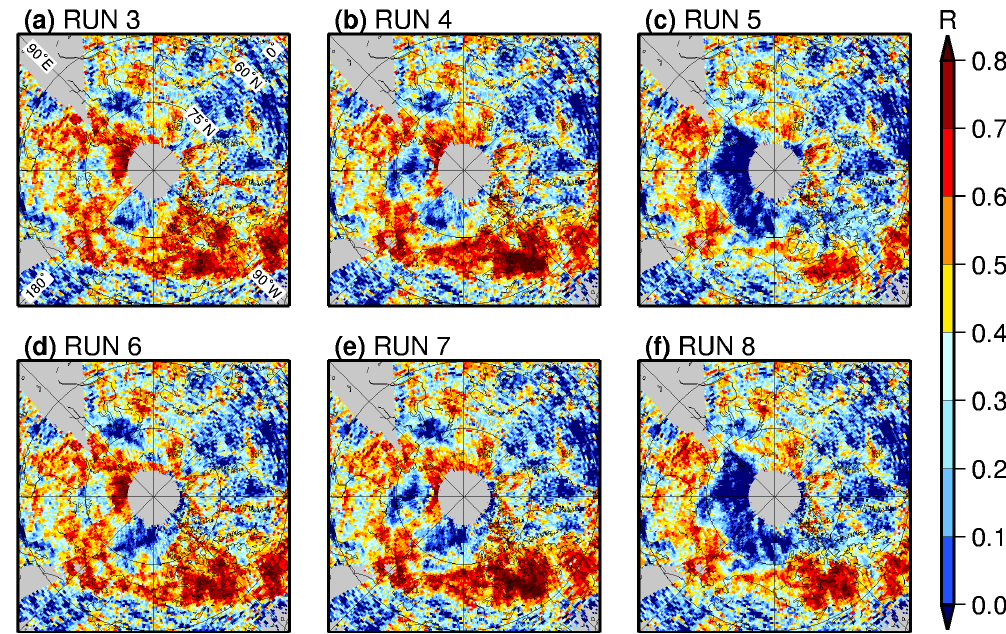
Fig. 13. Spatial distributions of temporal correlation coefficients between GEM-AQ BrO AVCDs and GOME-SLIMCAT tropospheric BrO VCDs in April 2001: (a) Run 3, (b) Run 4, (c) Run 5, (d) Run 6, (e) Run 7, and (f) Run 8. The GEM-AQ output (at the resolution of 0.88 ◦ × 0.88 ◦ in the Arctic core) is regridded to 0.5 ◦ × 0.5 ◦ used for the GOME-SLIMCAT dataset. Shaded by gray where the number of samples is less than 16.